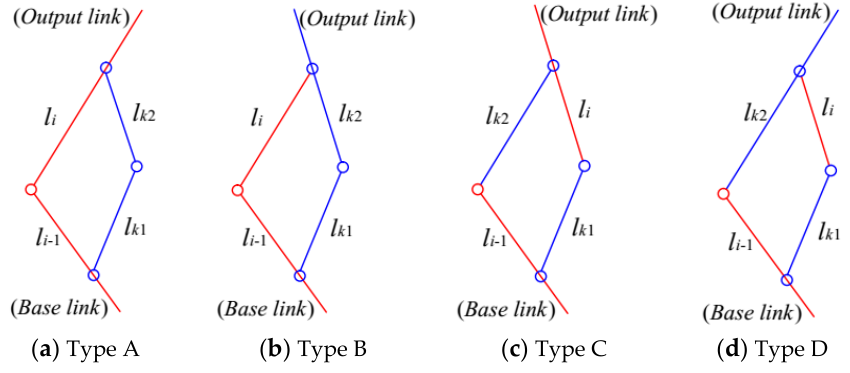
Figure 3. Four types of the local closed-loops.